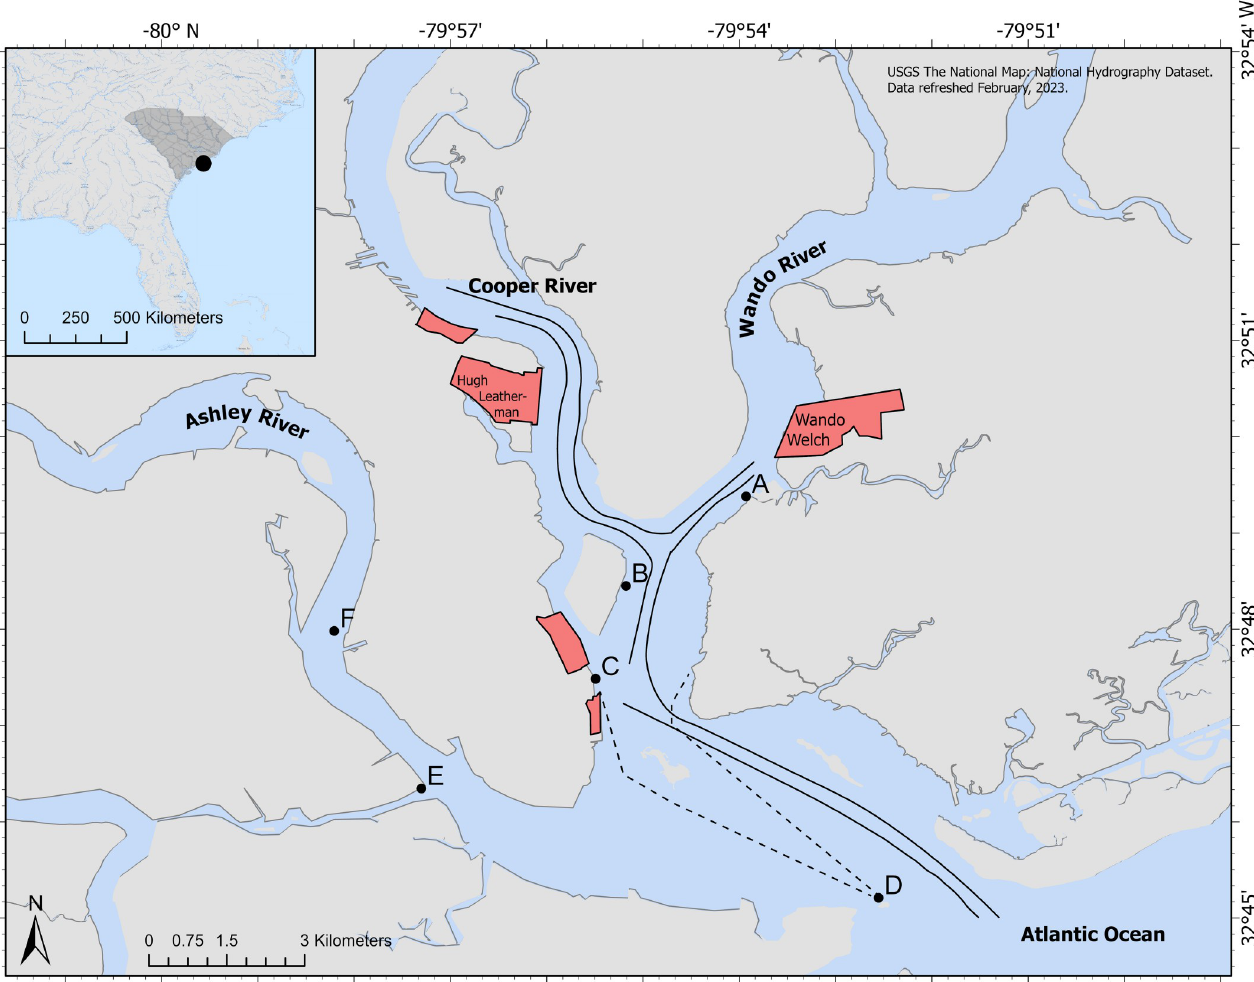
Fig 1. Passive acoustic monitoring station map. Charleston Harbor, South Carolina (SC) study area with passive acoustic recorder stations that were deployed from December 2017—June 2019. Stations include (A) The Wando River (B) Drum Island (C) the SC Aquarium (D) Fort Sumter (E) the Ashley River, and (F) the Citadel. Black lines show the shipping channel. Red shapes show shipping terminals. Black dotted lines show the ferry path to Fort Sumter from the SC Aquarium and Patriot’s Point. The base map is the USGS Hydro Cache Base Map.